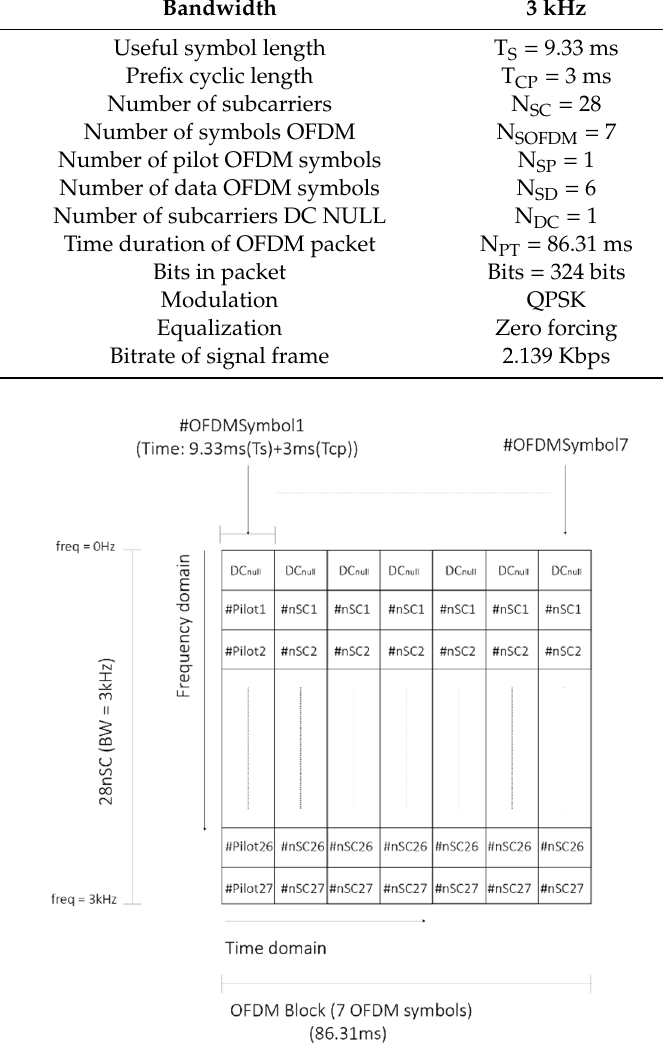
Table 3. OFDM configuration for NVIS with groundwave transmission .